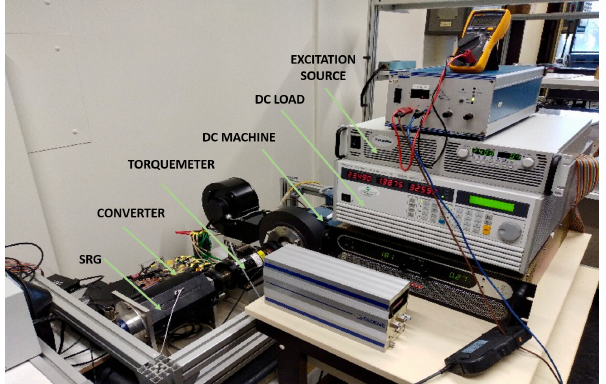
Figure 4. Experimental Switched Reluctance (SR) Generator